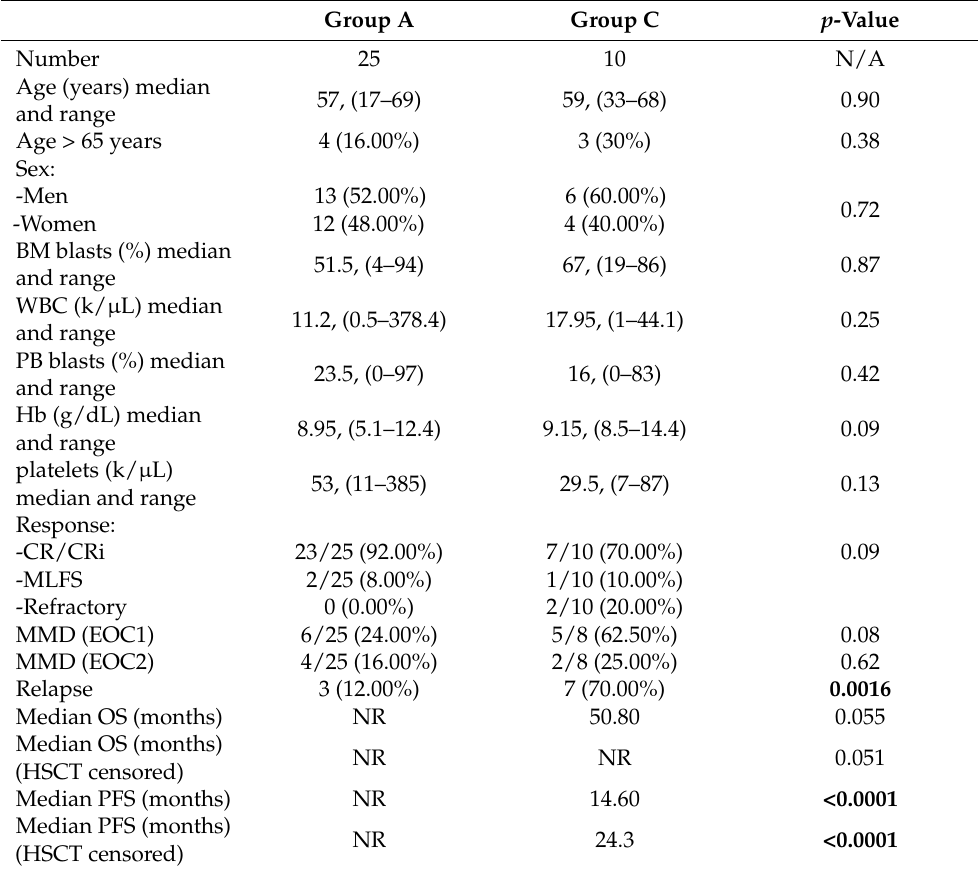
Table 3. Comparison between patients without (Group A) versus with (Group C) MDS-related gene mutations treated with intensive